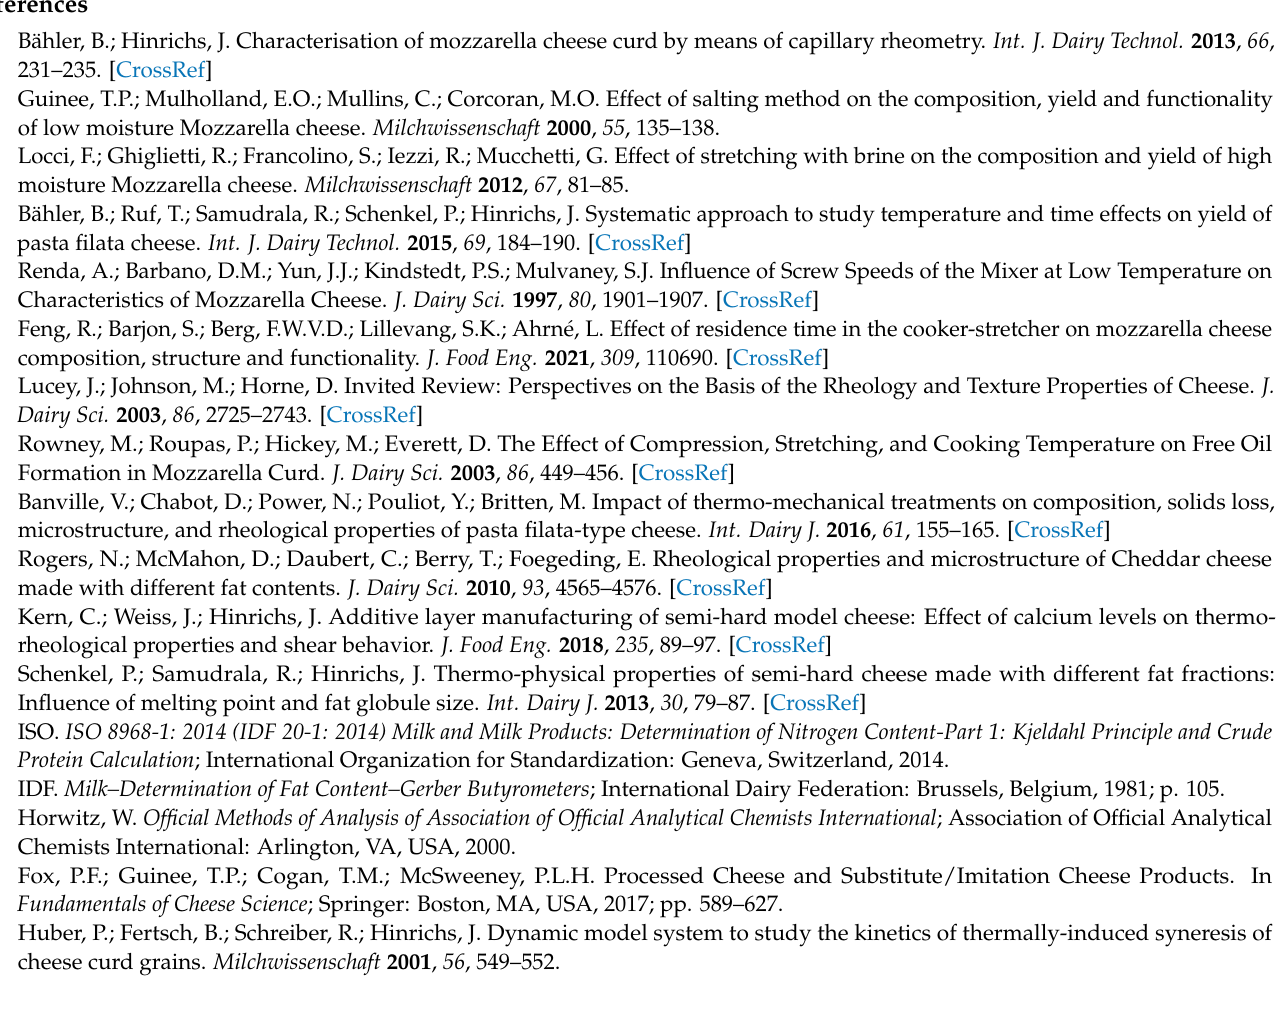
13 of 15 Figure 10. Schematic model proposed for kinetics of mass transfer during cooking of cheese curd. 4. Conclusions Cooking time and temperature induce significant changes in cheese curd composi- tion and rheological properties. Increase of water temperatures from 60 °C to 90 °C and long cooking times significantly accelerate these changes. A significant amount of water coats the curds surface after immersion in water, which has an important role both for mass and heat transfer. The total mass of cooked curds increased up to 10% during the first minutes of cooking, independent of the cooking temperature, although for longer cooking times the mass loss reached 7%. Fat was the main component lost from curd into the cooking water (<3.5% loss based on final curd mass), due to fat liquefaction and